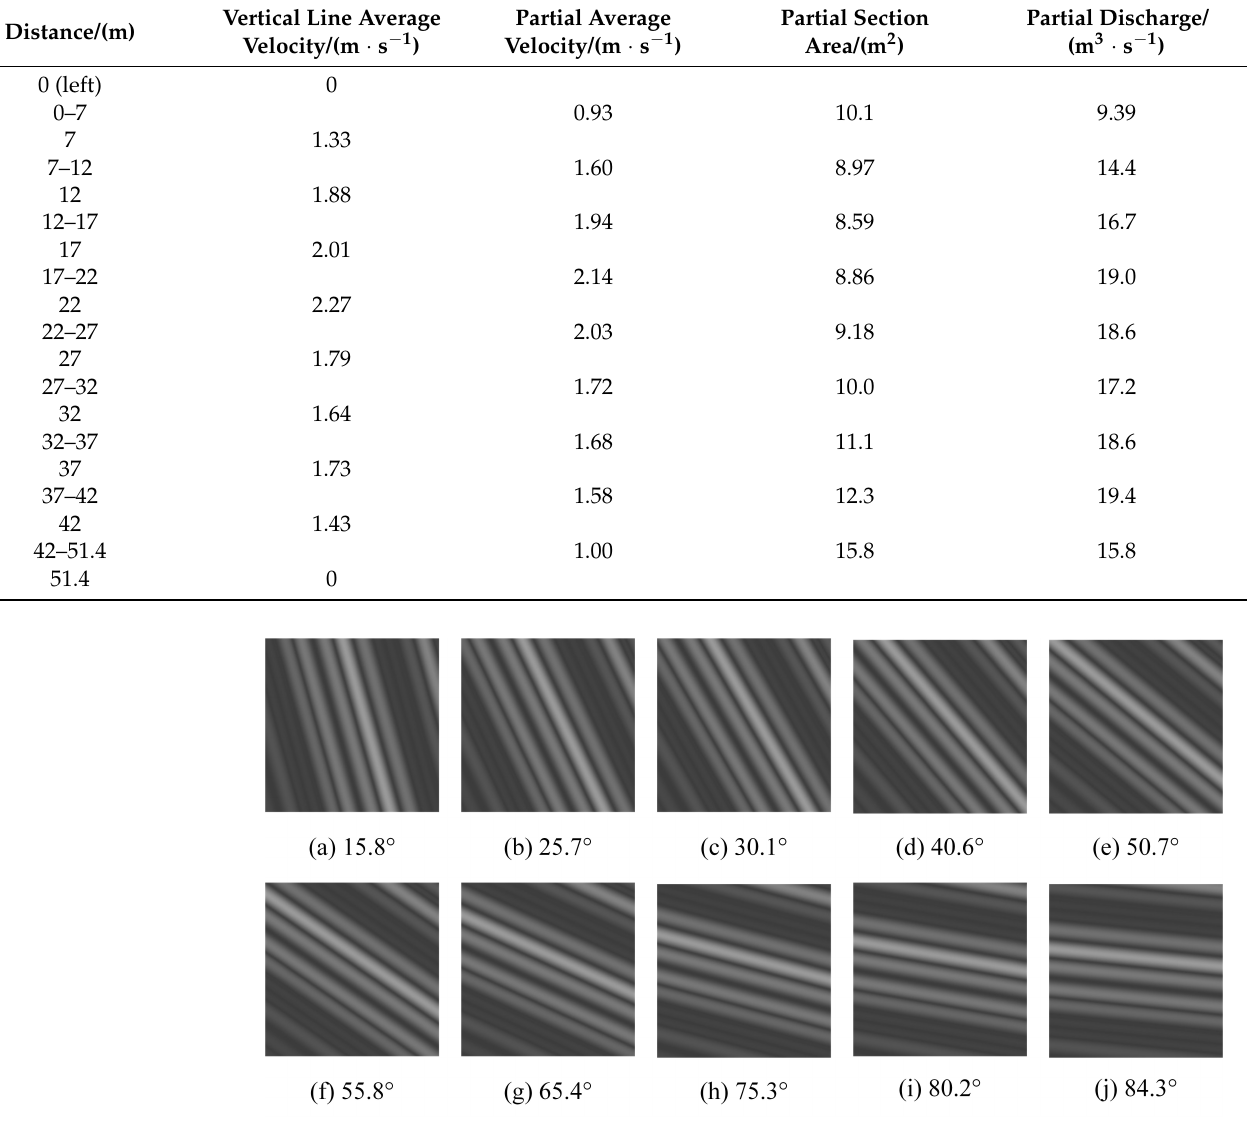
Figure 9. Synthetic images with different